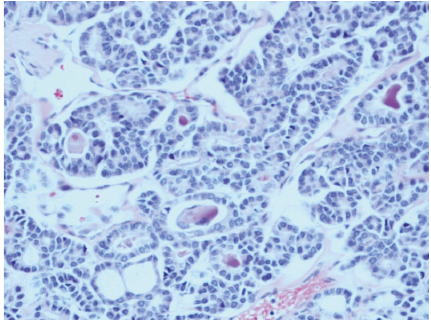
Figure 2: Well differentiated thyroid cancer with colloid.